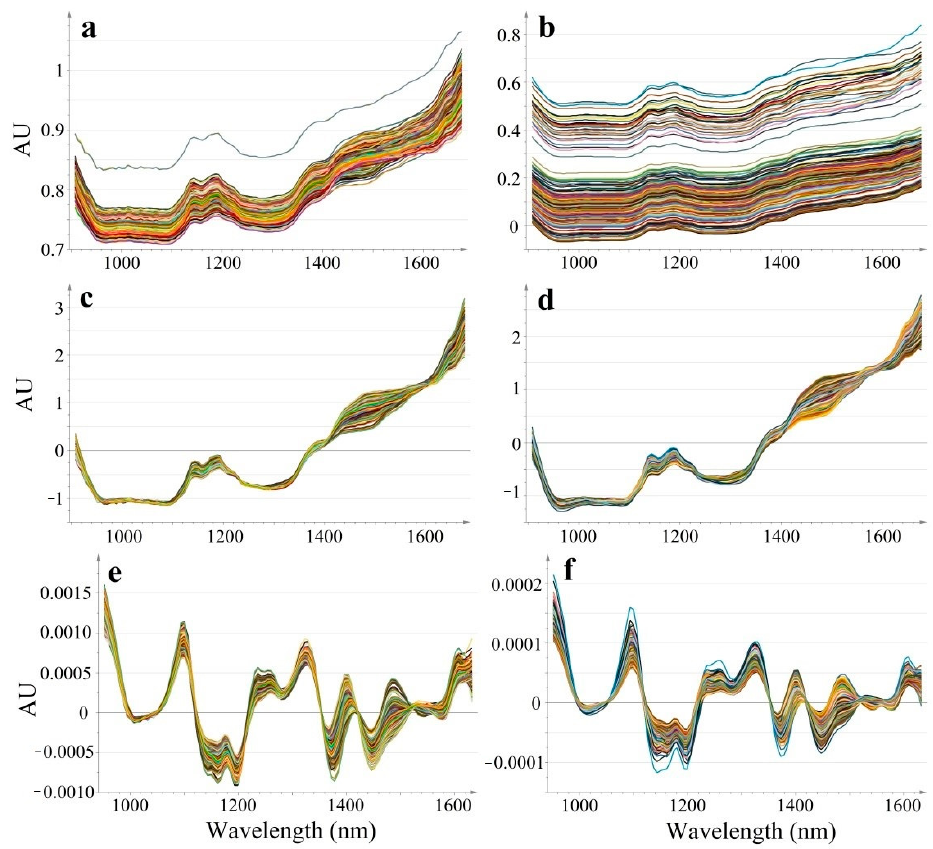
Figure 2. Raw and pre-processed spectral data recorded on calibration samples using static (at-line) and dynamic (in-line) acquisition modes (At-line: Raw ( a ), SNV ( c ), SD ( e ); In-line: Raw ( b ), SNV ( d ), SD ( f )).